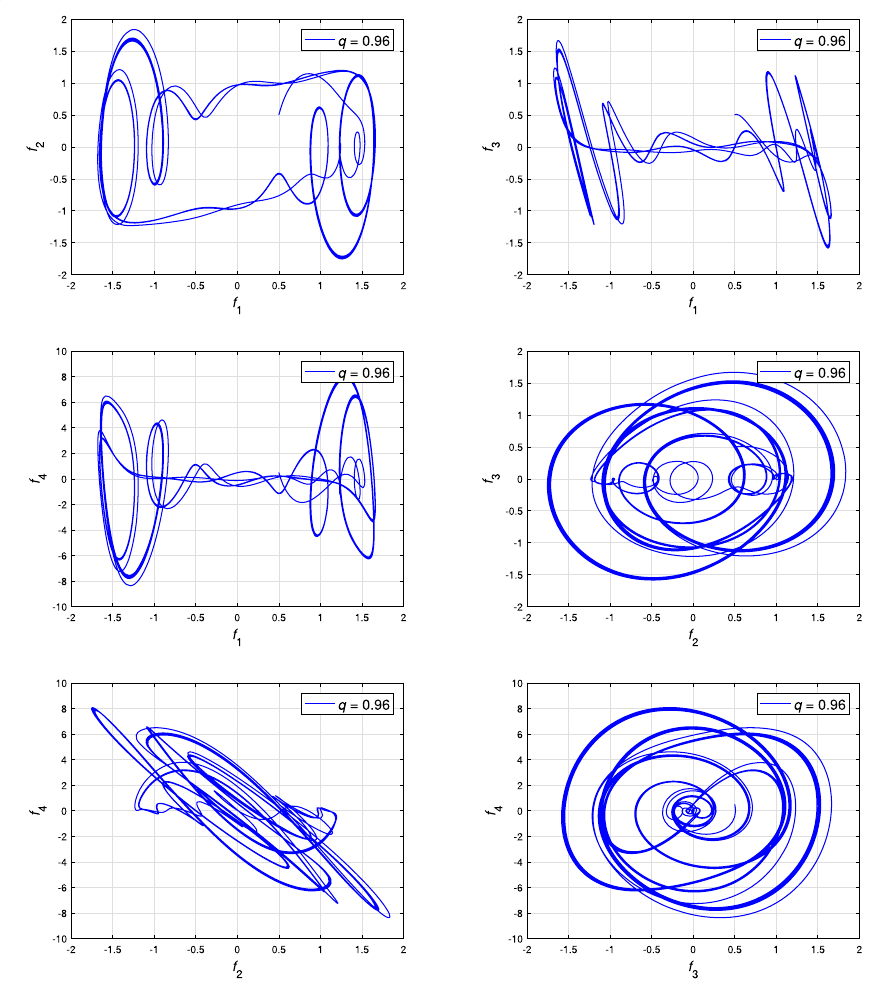
Figure 4 The phase planes of the fractional chaotic system (6) for q =